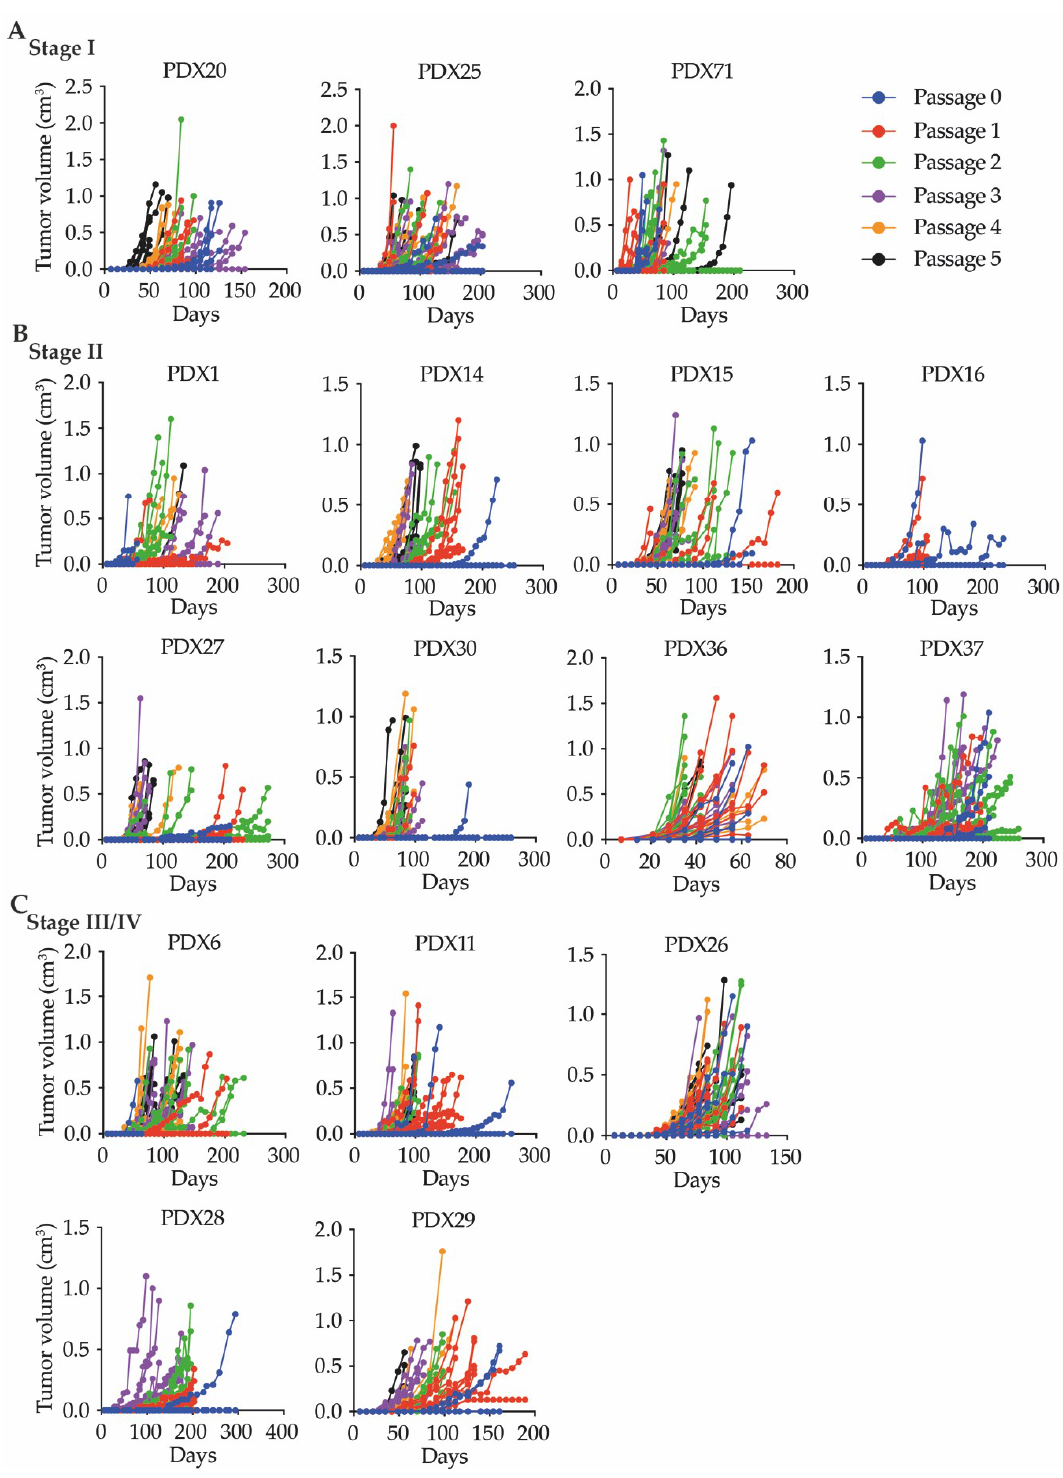
Figure 5. Patient-derived xenograft tumor growth. Passages are indicated in different colored symbols, with P0 (red), P1 (blue), P2 (green), P3 (purple), P4 (orange), and P5 (black). Each line represents an individual tumor. Data are presented for at least two mice per passage, with two tumors per mouse. PDX lines are grouped based on the stage of the parental tumor ( A ) stage I; ( B ) stage II; and ( C ) stage III/IV.